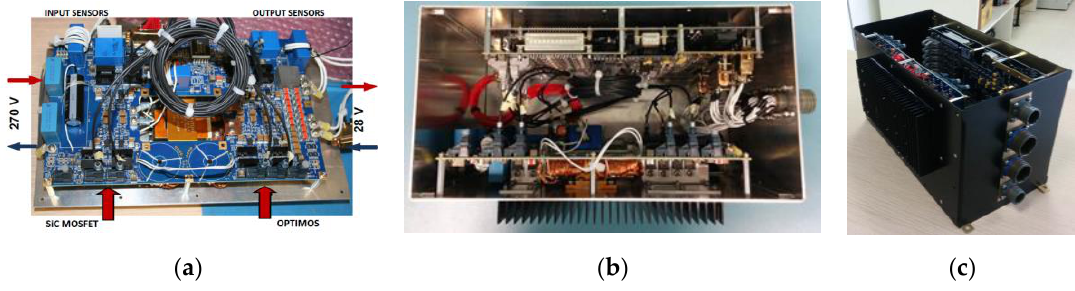
( b ) Figure 8. Dynamic response characterization of the converter (simulation results): closed-loop Bode plots ( a ) and system step response at different power levels ( b ). The design phase also addressed EMI filtering on the 270 V side, ensuring compliance of standard avionic requirements (e.g., MIL-STD-704F) with a standard and compact damped LC filter design. 2.3. Experimental Characterisation Figure 9 shows the engineered TRL6 level DC-DC converter, including control platform and flight-like enclosure, with details of connectors and wiring. Figure 10a shows some representative voltage and current waveforms at about 50% load (600 W) and Figure 10b summarizes measured efficiency data, still at 600 W, as a function of the input voltage in the range 230–290 V. Efficiency over load in the forward and backward power flow direction is reported in Figure 11: as can be seen, in the design and engineering of the converter, attention was taken to ensure high performance at relatively low loads; such approach is dictated by the actual mission profile of the converter, which foresees low-load operation as the most frequent condition, with the requirement to deliver the full power capability limited only to very short time durations. Therefore, it is very important to consider energy (as opposed to power ) efficiency; that is, the integral over time of the power losses at the various load conditions to maximize overall aircraft efficiency. Moreover, it should be noted that due to the intended parallel operation of the converters, more units can be made to work at an optimized efficiency level even when the full capability of one single converter is not exhausted: for instance, if the total power demand is 900 W, it is more efficient to run tow cells in parallel than a single cell. The